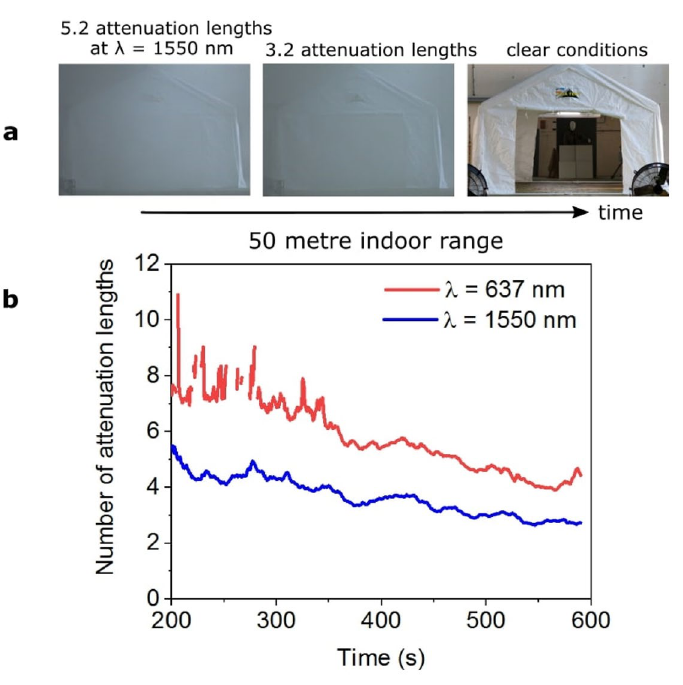
Figure 2. ( a ) Photographs of the target scene taken in visible light with a compact digital camera as the obscurant disperses during a measurement set. Over several minutes, the obscurant disperses and the attenuation between the LiDAR transceiver and the target reduces. The corresponding number of attenuation lengths at λ = 1550 nm between transceiver and target is given for each image. ( b ) A comparison of the number of attenuation lengths as a function of time over the duration of a measurement set for wavelengths of 1550 nm and 637 nm. The λ = 1550 nm measurements were obtained using the bistatic depth imaging system at a stand- off distance of 50